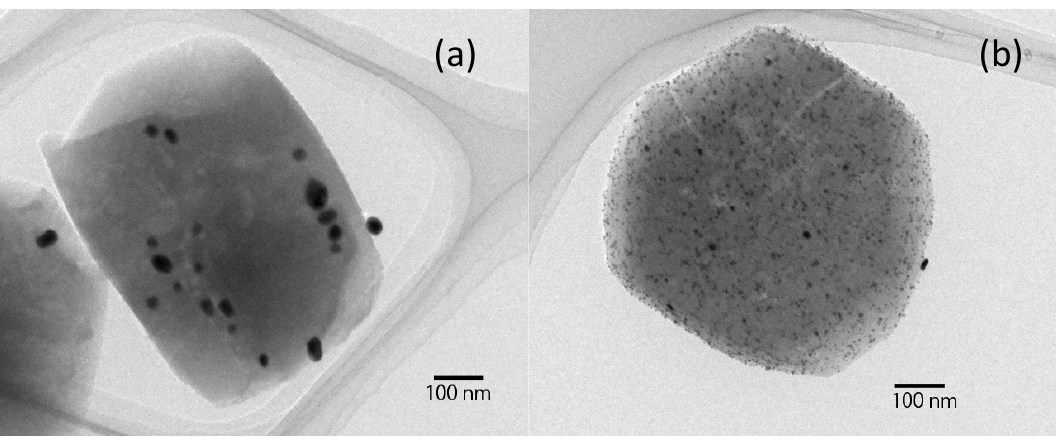
Figure 5. TEM images of Au/USY thermally treated in 6% H 2 diluted with Ar at ( a ) 473 K; ( b ) 773 K; ( c ) 973 K and ( d ) 1073 K. Samples were stored in the dark for more than one